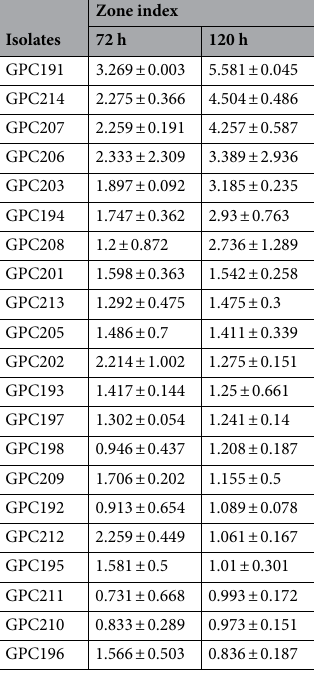
Table 1. Zone indices of the organisms at 72 and 120 h.